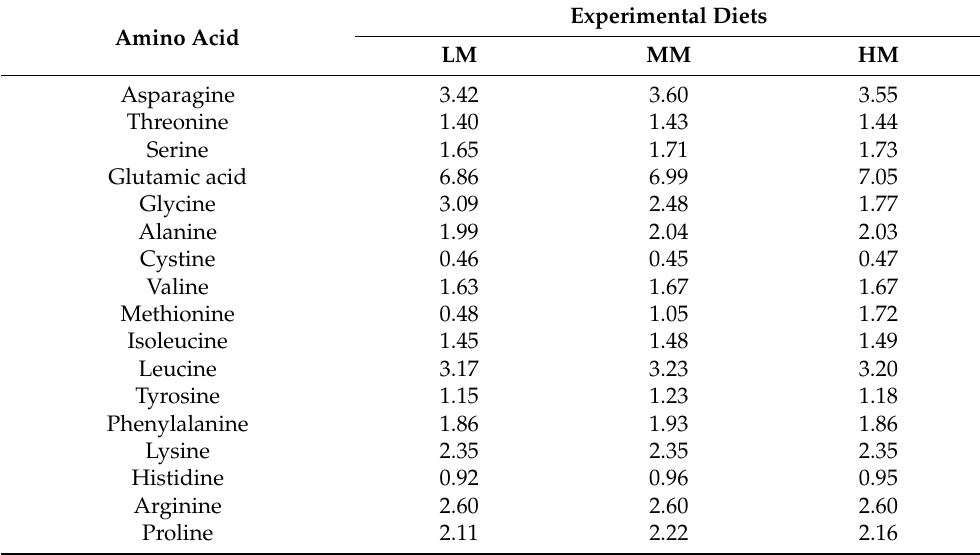
Table 2. Amino acid composition of diets (% dry